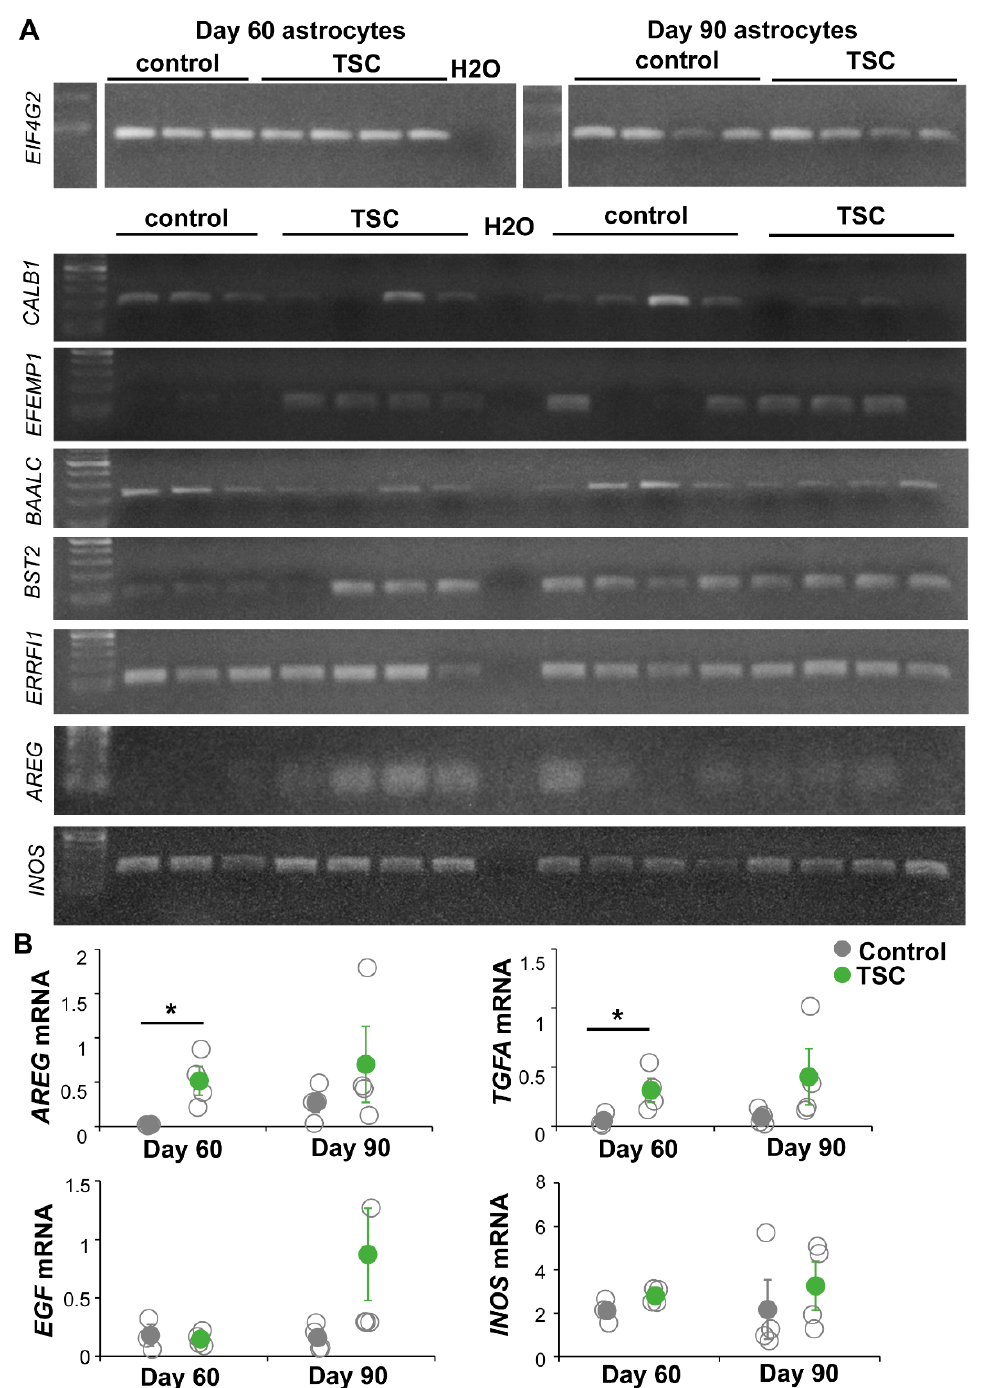
Figure 4. EGF signaling changes are sustained in day-90 astrocytes. The expression of selected DEGs and EGF signaling components are tested in day-60 and day-90 astrocytes. ( A ) PCR products of DEGs CALB1, EFEMP1, BAALC, BST2, ERRFI1 and AREG; INOS which is a downstream target of EGF signaling; and housekeeping gene EIF4G2. Most of the differences in day-60 astrocytes are still observed at day 90. ( B ) Bands of EGF signaling components were quantified and corrected for housekeeping gene expression. Significant changes were only observed in AREG and TGFA in day-60 astrocytes, but all genes show a trend to increased expression in day-90 astrocytes. ( B ) Data points represent data for each iPSC line with solid data points representing the mean per condition ± SEM. * = p < 0.05, statistical test: independent samples t test.